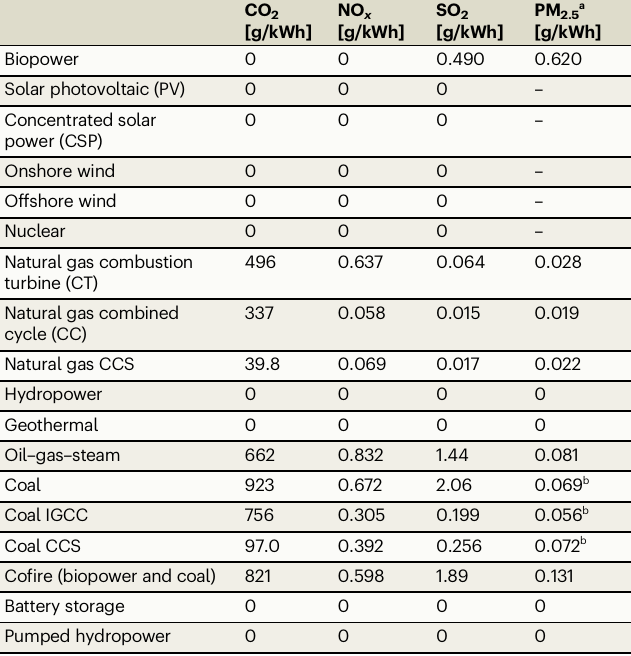
See Table S-2 in SI forsources: dashed lineindicates noreportedvalue. a For renewable energyandnuclear technologies, we assumed PM operating emissionswere negligible. b